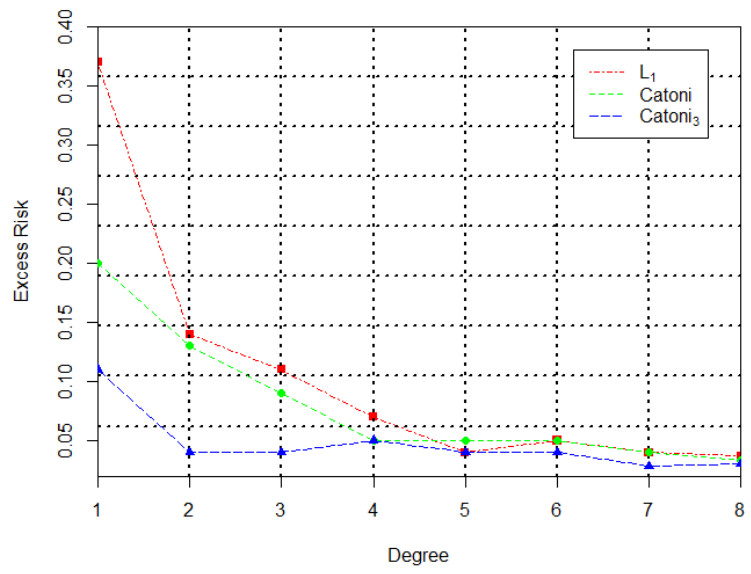
Figure 3. Excess risk varies with degrees of freedom.